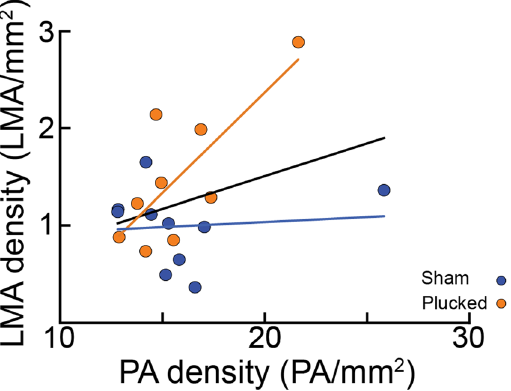
Figure 4. Relationship between number of LMAs and PAs. The number of PAs vs the number of LMAs within the barrel, forelimb, and hindlimb regions. While the number of PAs and LMAs trend together, the two vascular features were not significantly related (Linear regression fit by least squares, pooled data: p > 0.42, Bonferroni corrected, t(17) = 1.54; plucked: p = 0.051, Bonferroni corrected, t(7) = 3.10; sham: p > 0.79, Bonferroni corrected, t(8) = 0.28), suggesting that they develop independently. Each circle represents an individual mouse. Lines indicate linear